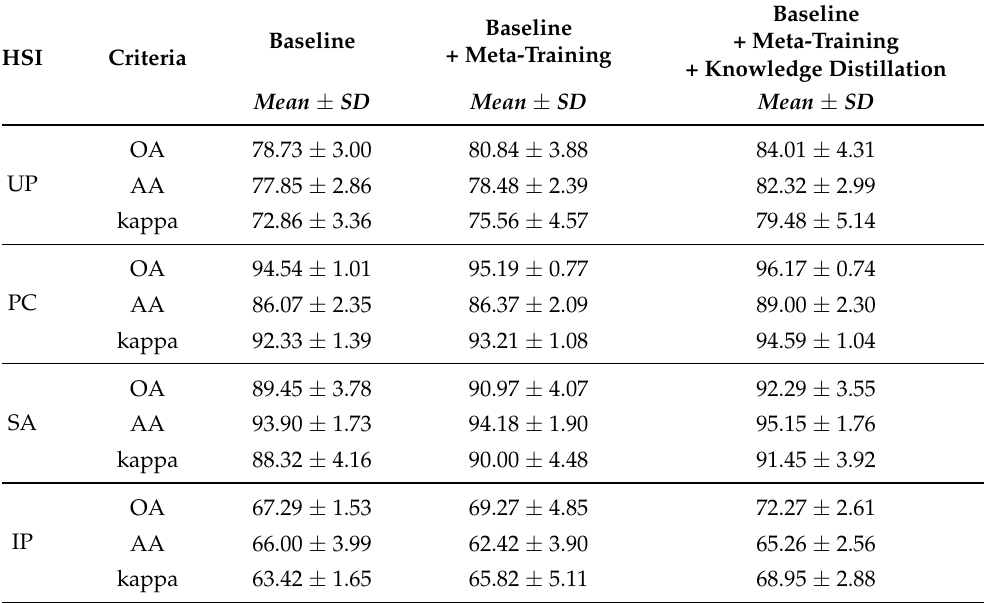
Table 3. The classification results of different variants of the proposed method. SD denotes the standard deviation of 10 experimental